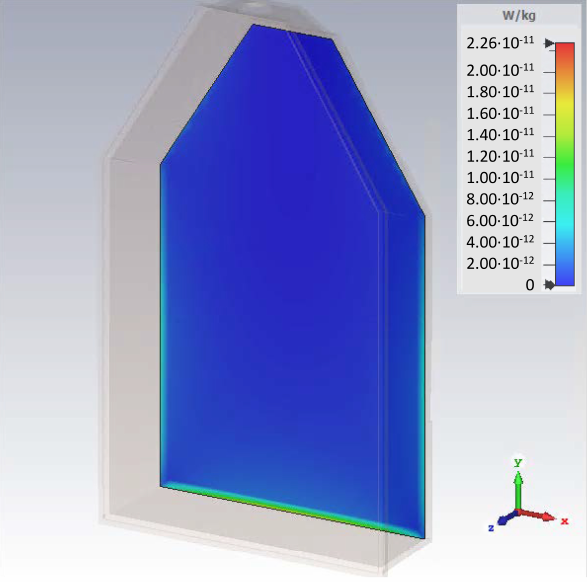
Figure 6. SAR distribution in a thin layer of bone marrow cells grown in the culture fl ask T175 (spatial visualization).